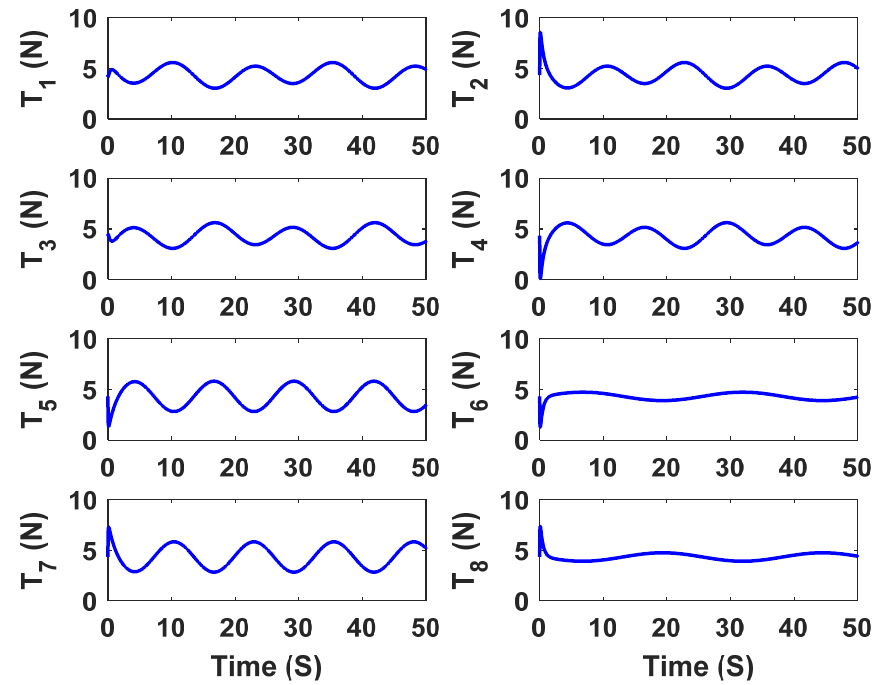
Figure 11. UAV motors thrusts in the second control case.